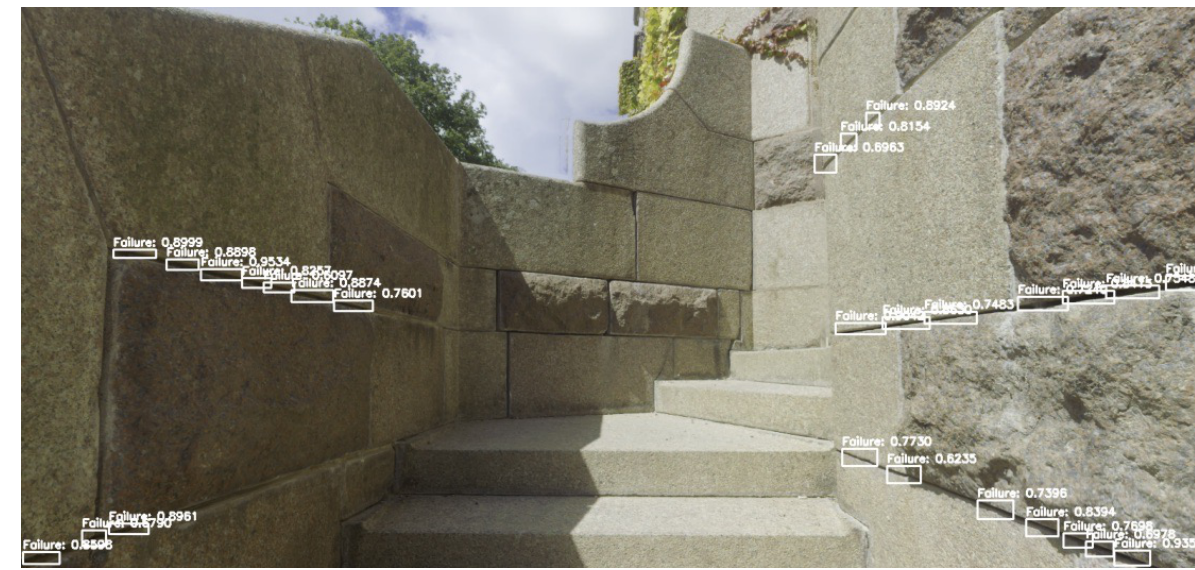
Figure 5. Image facing stairs